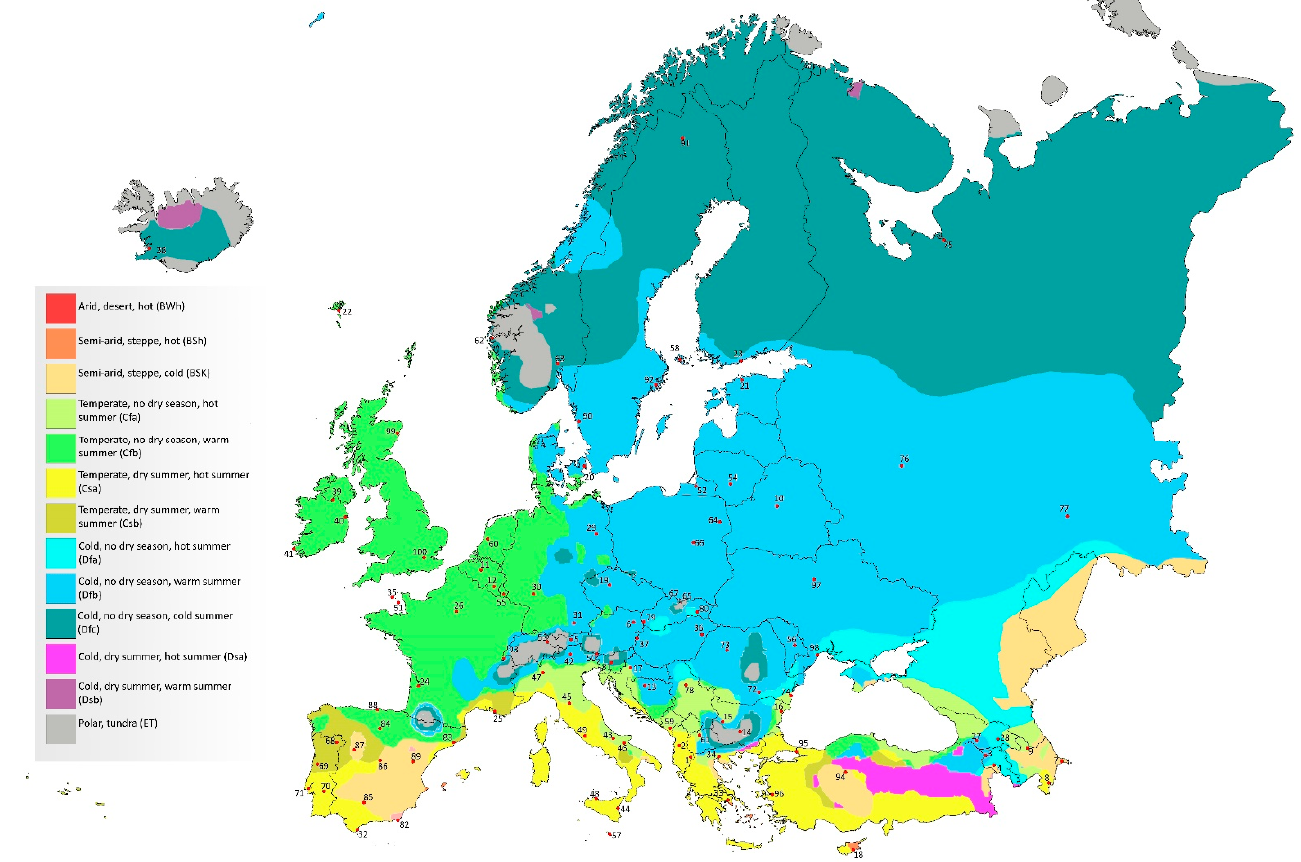
Figure 3. Position of the 100 representative locations. Different colours indicate different Köppen–Geiger classes [32].